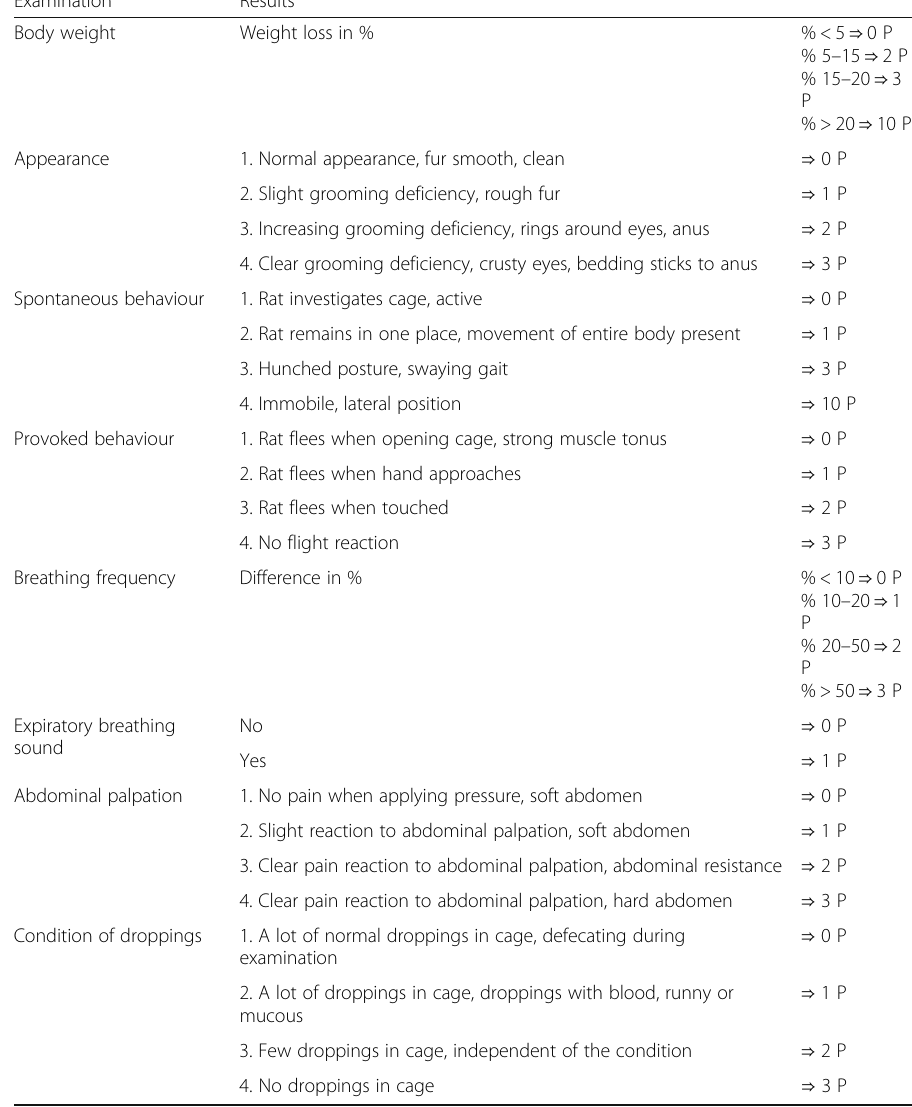
Table 1 Clinical score (all changes refer to the baseline) Examination